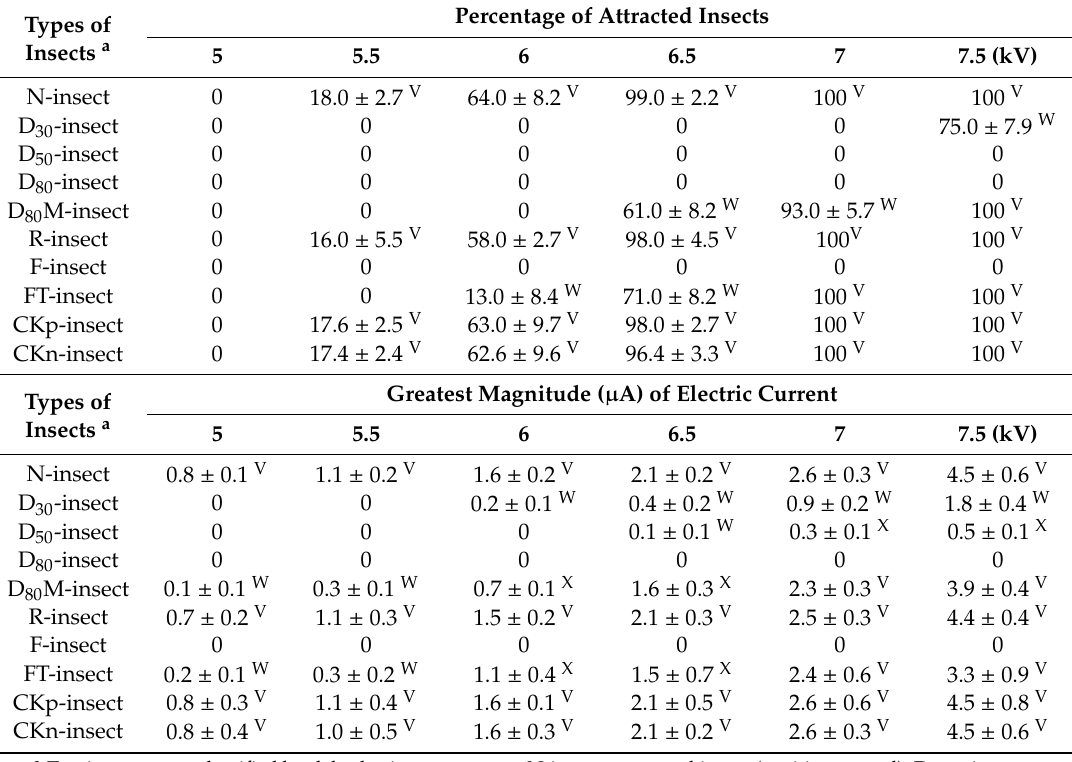
Table 1. Percentages of treated and untreated houseflies attracted to the charged insulated plate in a static electric field (SEP) and greatest magnitude of the insect-derived transient current generated at the time of